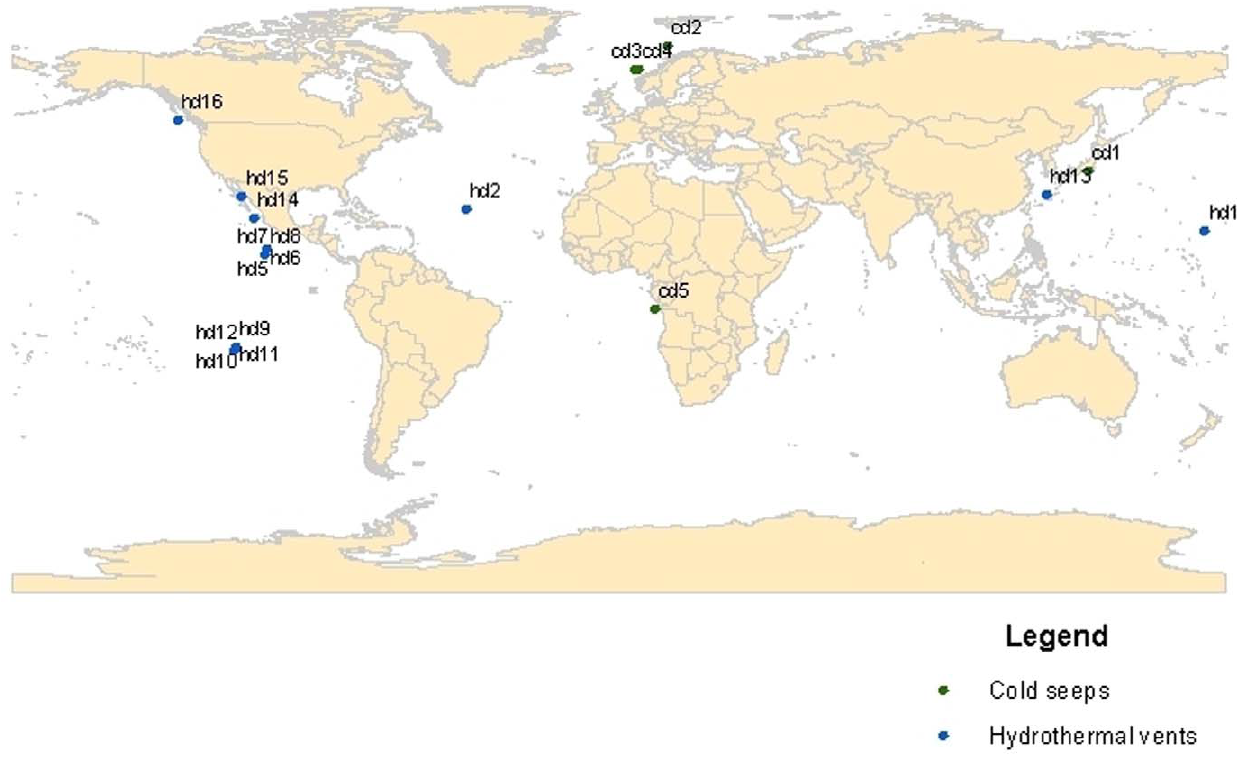
Figure 1. World map with indication of study sites on nematodes taxonomic composition from deep-sea vents and seeps.